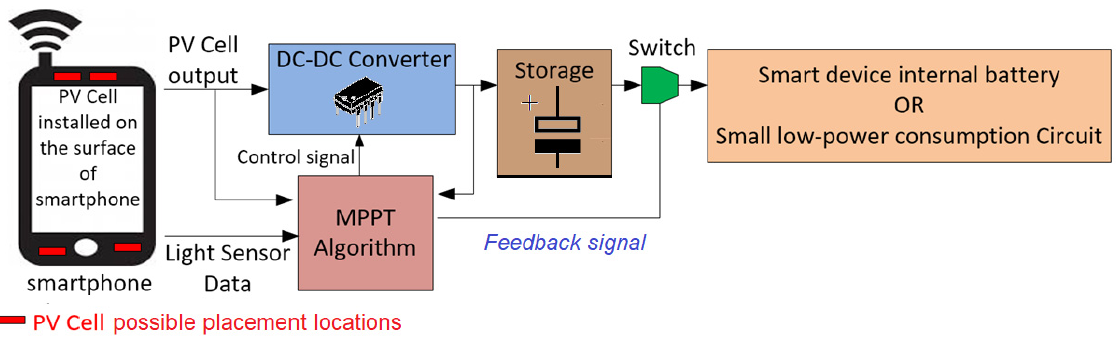
Figure 1. Overall procedure of the proposed methodology.